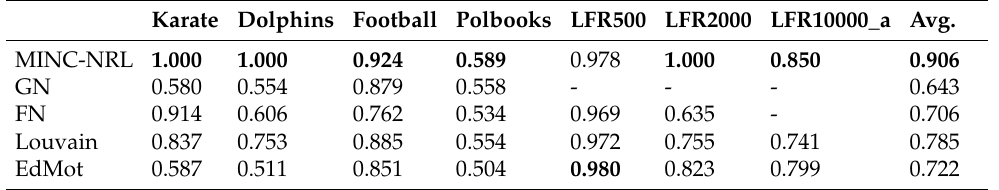
Table 5. NMI of MINC-NRL compared with other algorithms.